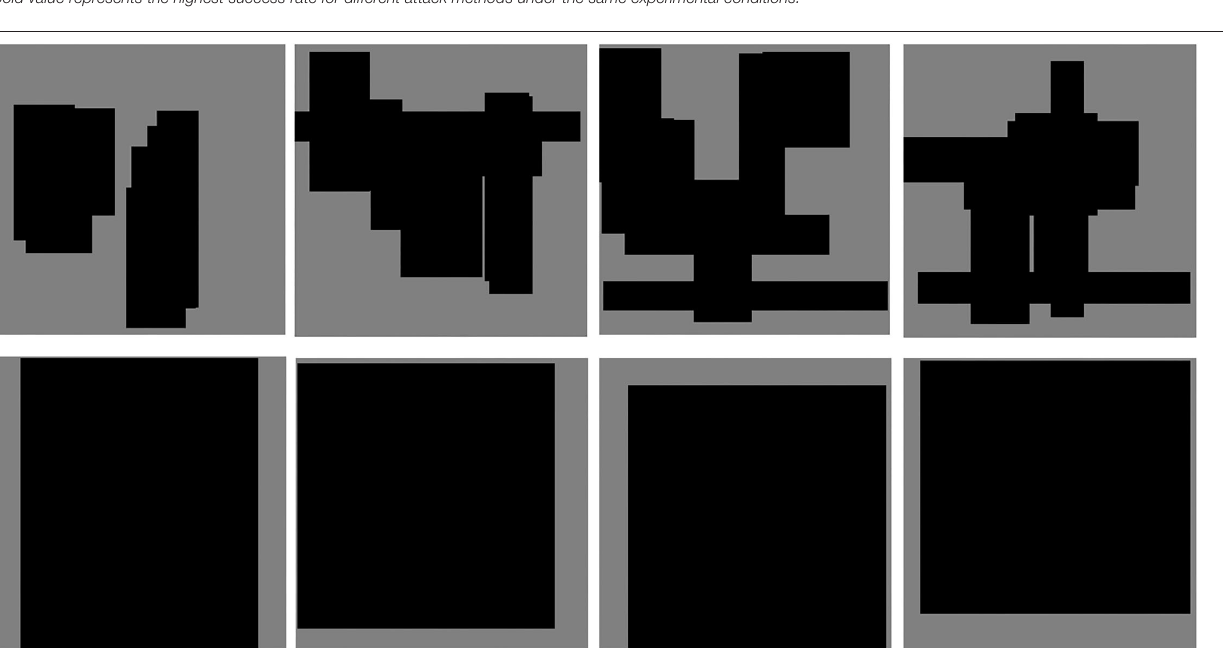
Frontiers in Neurorobotics |